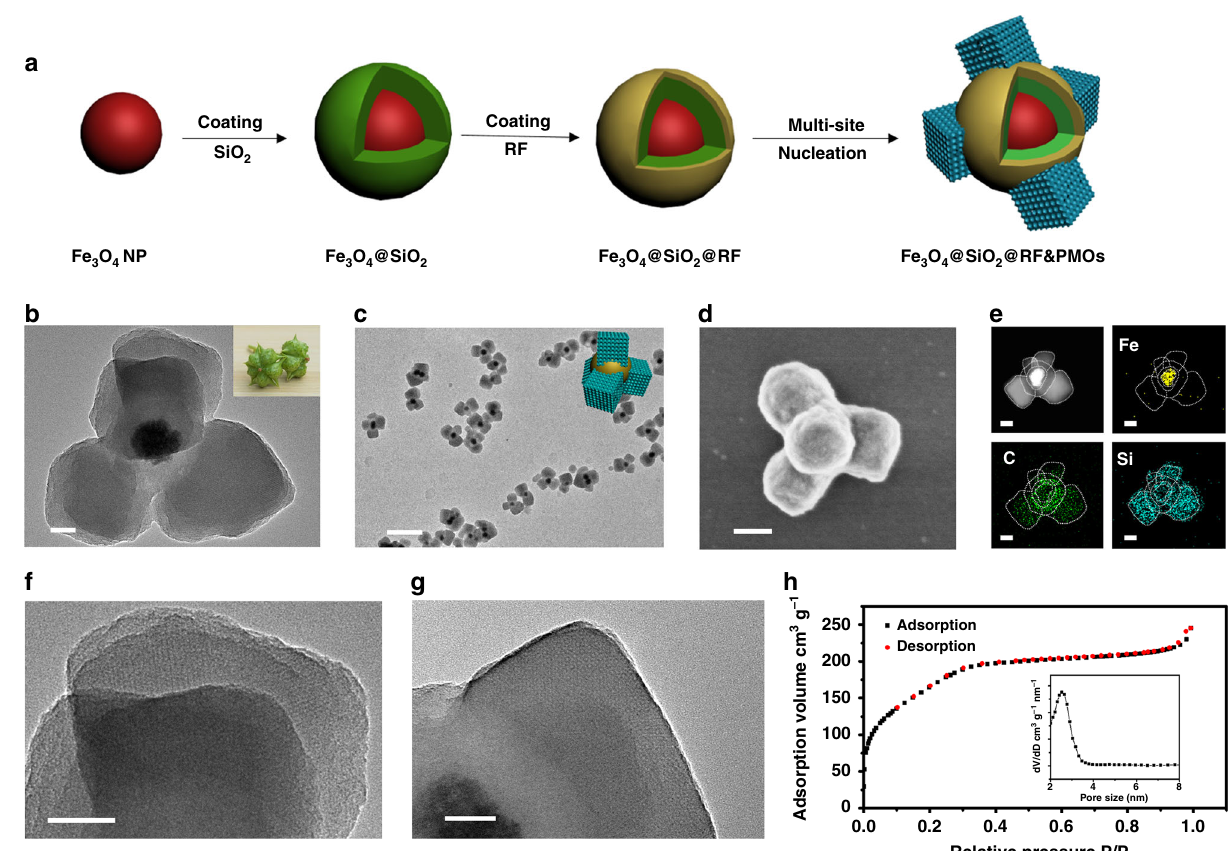
Fig. 1 Synthesis and characterization of tribulus-like tetra-pods nanocomposites. a Fabrication process scheme of the tetra-pods Fe 3 O 4 @SiO 2 @RF&PMOs nanoparticles based on the surface-kinetic mediated multi-site nucleation strategy. b , c TEM images with different magni fi cations, d SEM image and e element mapping of the tribulus-like tetra-pods Fe 3 O 4 @SiO 2 @RF&PMOs mesoporous nanocomposites. Inset in b : a digital photo of tribulus seeds; Inset in c : 3D structural model of the tetra-pods Fe 3 O 4 @SiO 2 @RF&PMOs nanoparticles. f , g HRTEM images of the typical PMO pods of tetra-pods Fe 3 O 4 @SiO 2 @RF&PMOs nanoparticles along f [210] and g [001] zone axis. h The nitrogen sorption isotherms and pore size distribution (inset) of the tetra-pods nanoparticles. Scale bars represent 50 nm in b , f , g , 100 nm in d , e , and 500 nm in c . Source data underlying h are provided as a Source Data fi